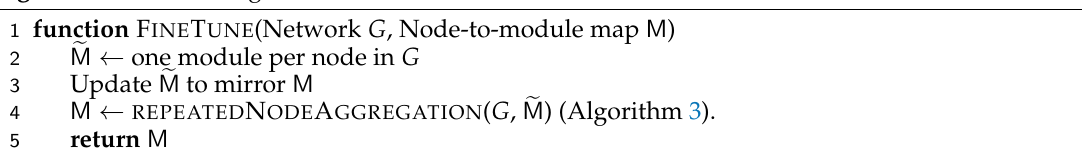
Algorithm 5 Fine-tuning